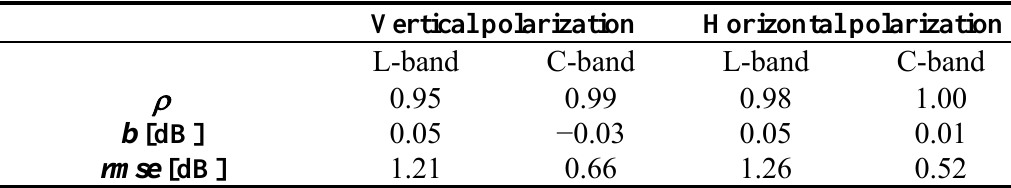
assumed as an additional input i